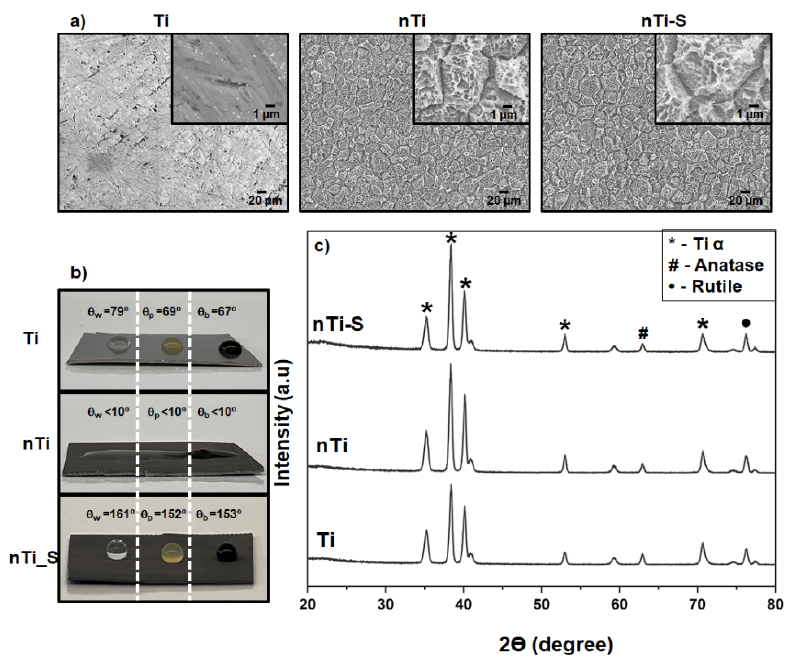
Figure 1. ( a ) Representative SEM images of different surfaces. Images were taken at 500 × , and image inserts depict 5000 × magnification. ( b ) Apparent contact angle measurements using Milli-Q water, PRP, and blood on different surfaces. ( c ) XRD intensity peaks of different surfaces (n min = 9).